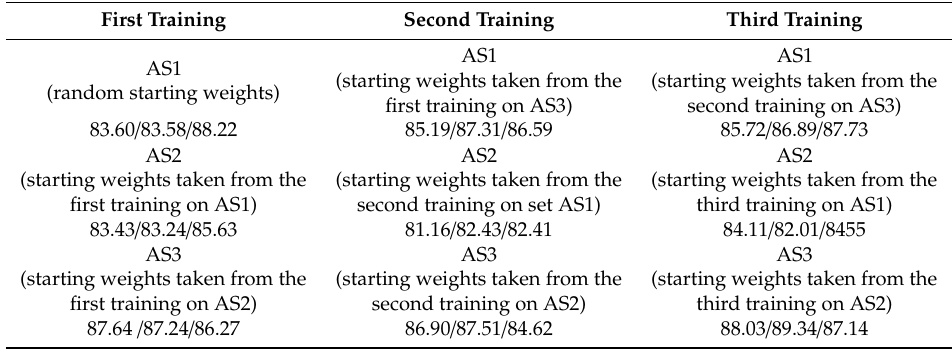
Table 15. Recognition rates [%] obtained using weight transfer in the BiLSTM network for the MSR 3D Action (ten-fold cross-validation LOSO) – all features / features in variant V1 / features in variant V2.